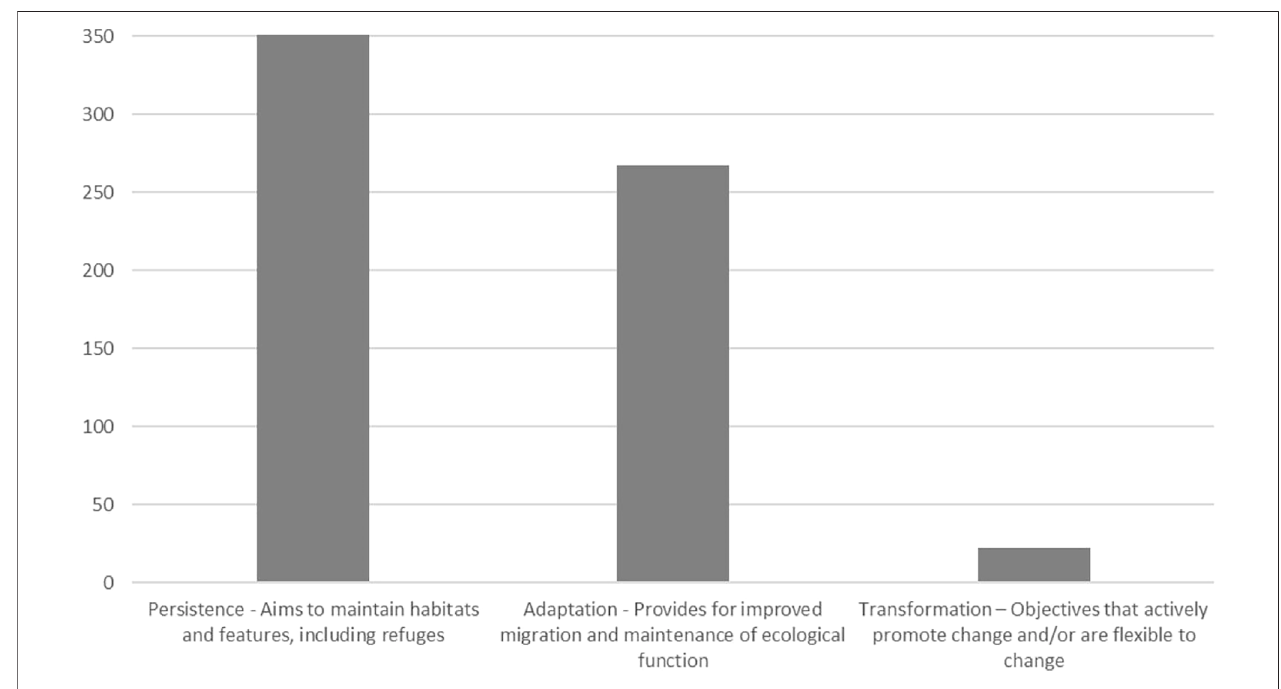
FIGURE 1 | Number of existing fl ow objectives that meet the suggested climate change adaptation objectives.